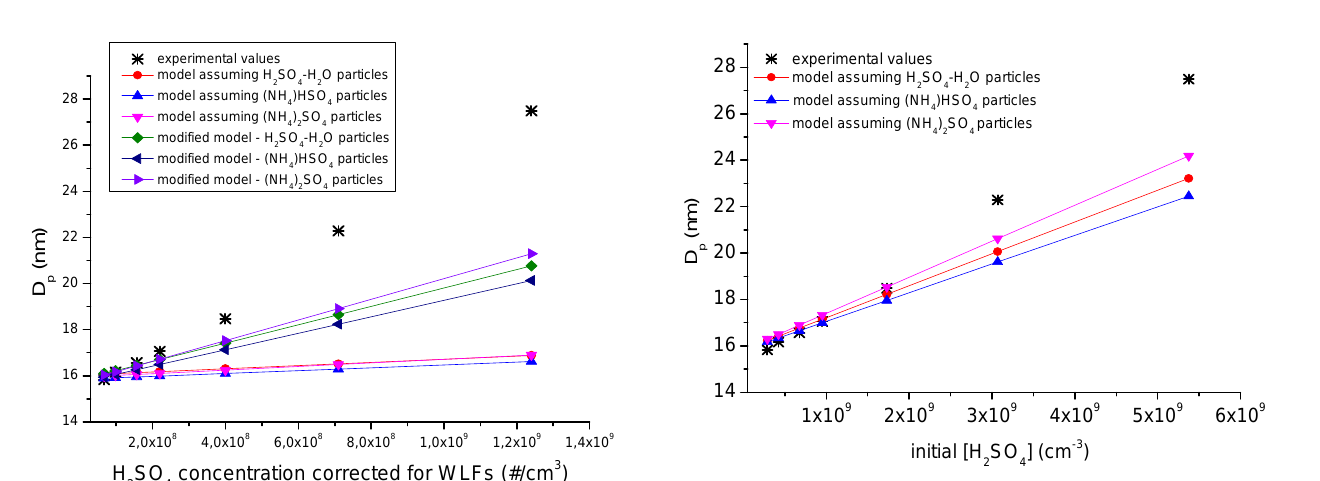
Figure 8. The comparison of the experimental median particle di- ameters from a measurement conducted at T = 283K, with an RH of ∼ 30% and a residence time of 60s, values predicted theoret- ically from a model using the H 2 SO 4 concentration corrected for wall losses, determined according to Hanson and Eisele (2000) and a modified model, accounting for a system-specific wall loss coeffi- cients (Brus et al., 2011b).